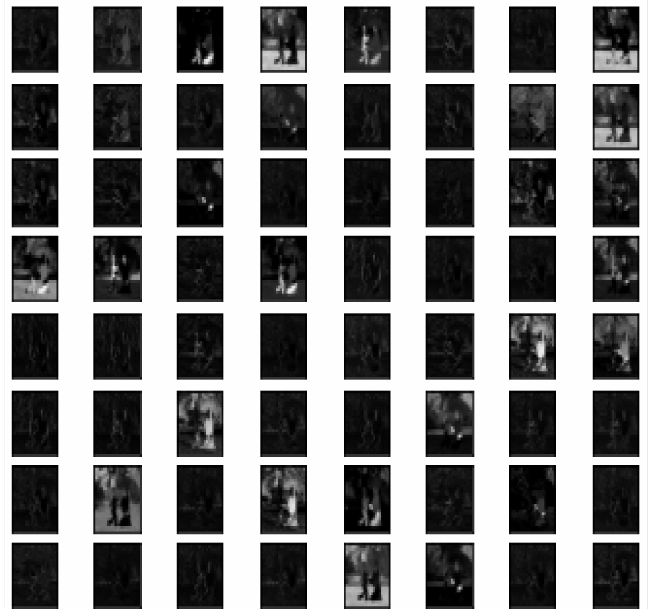
Figure 10. Image features of first 6 filters in the first convolutional layer of the VGG-19 model.